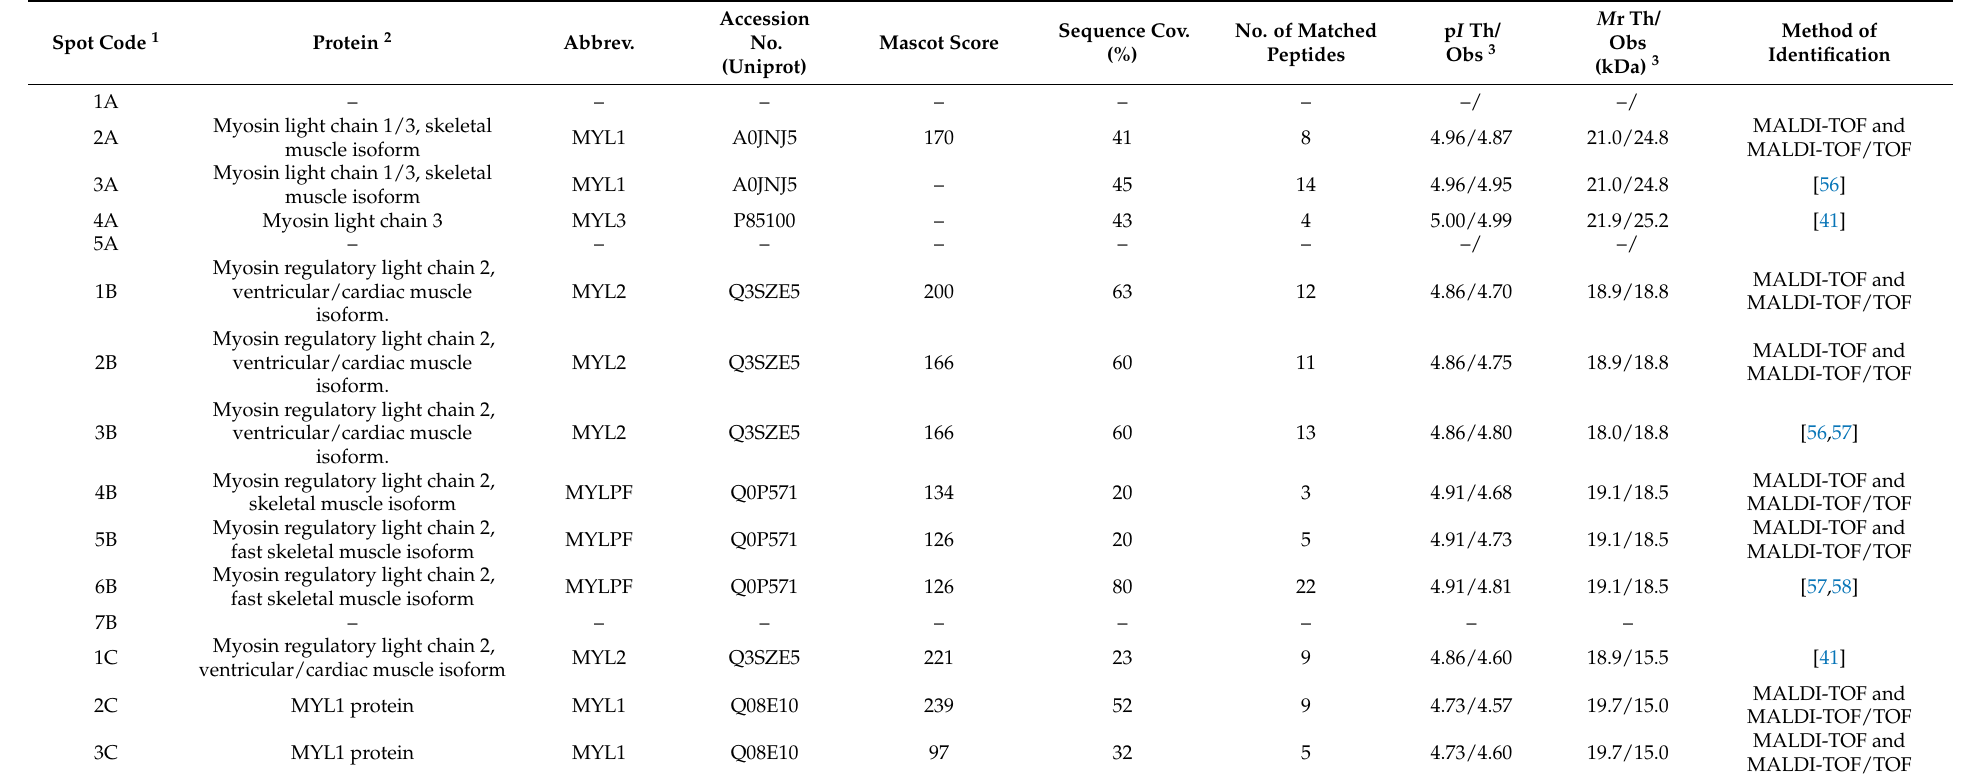
Table 1. Identification of protein spots selected from three representative 2-DE gel by MALDI-TOF, MALDI-TOF/TOF MS or contrasted with the literature in those unidentified spots by